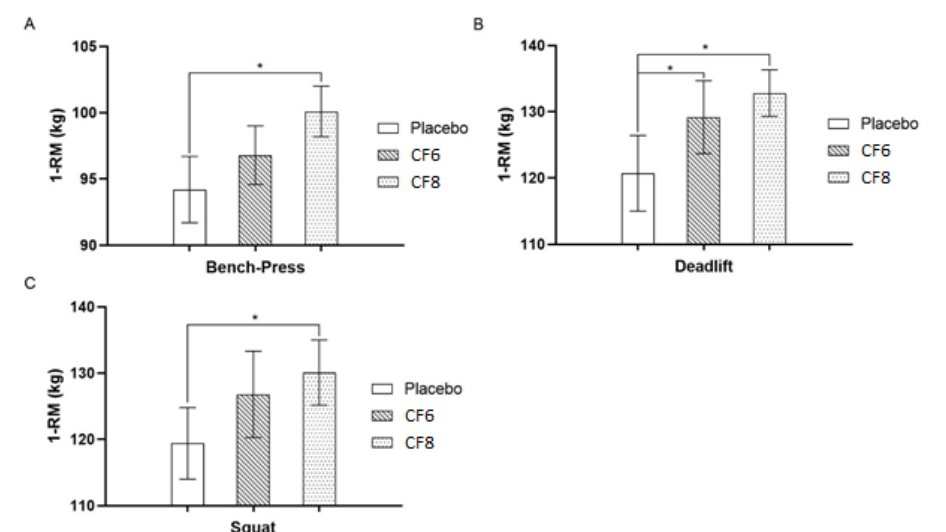
Figure 2. Results of 1-RM on Bench Press, Deadlift and Squats. Figure 1. ( A ) Effect of different doses of caffeine during the bench press strength analysis; ( B ) Effect of different doses of caffeine during the deadlift strength analysis; ( C ) Effect of different doses of caffeine during the squat strength analysis. * = significant difference ( p < 0.05) compared to placebo .